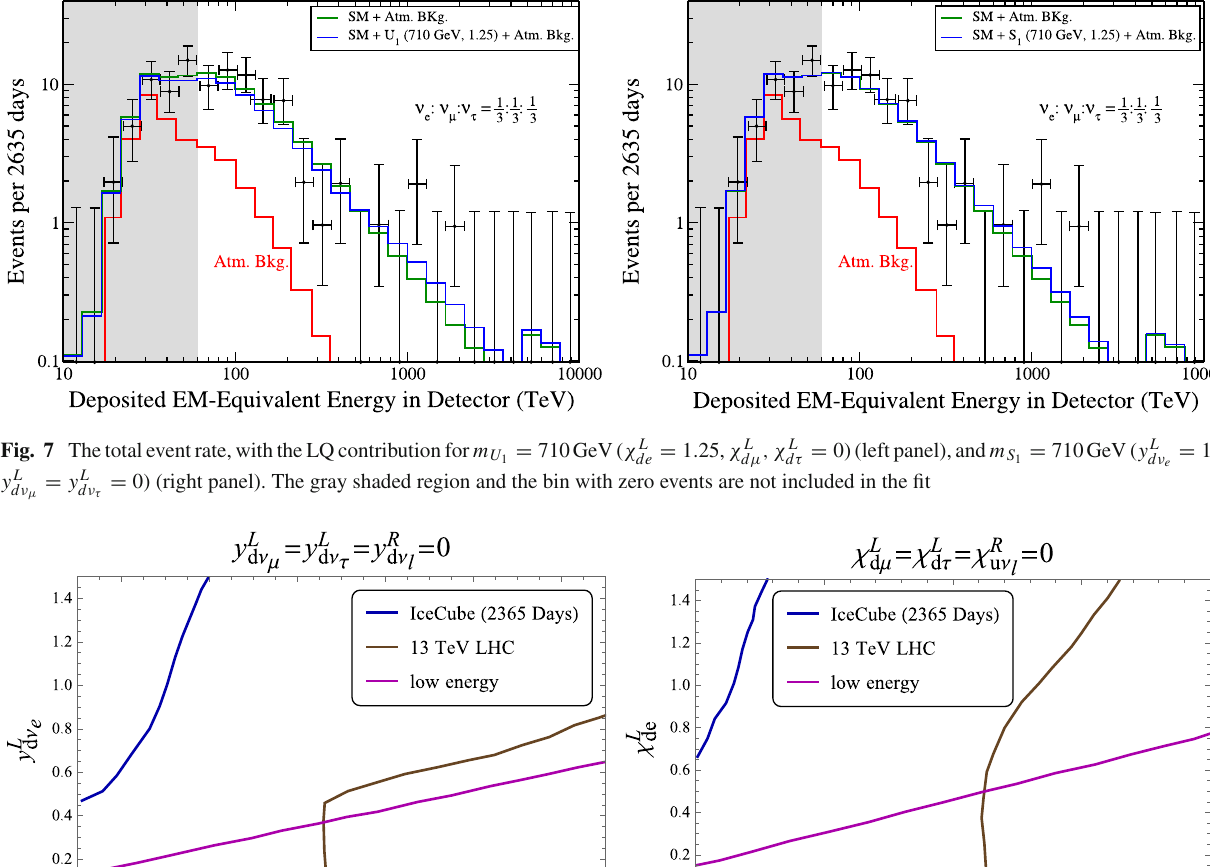
Fig. 8 The m S left of the brown line is currently disallowed at 95% C.L. by the 13TeV - y L (left panel) and m U - χ L (right panel) parameter d ν e de 1 1 LHC data on the LQ direct searches via the jj νν , jjee , and jj μμ final space where the region above the blue line is disallowed at 2 σ level states. The single LQ production is also included in the S 1 from 2635 days of IceCube data. We also show the low energy disal- lowed region (space above purple line) at the 2 σ level. The region to the